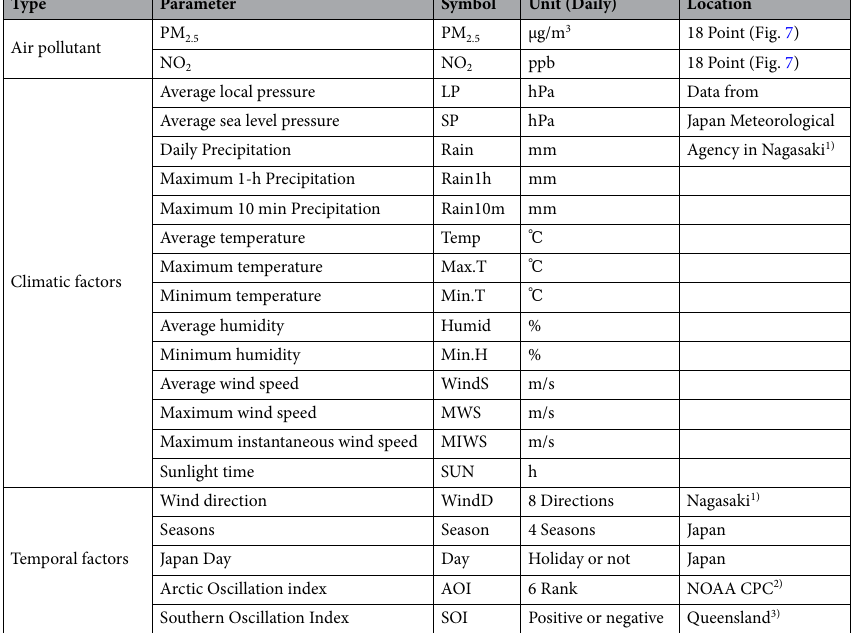
Table 6. Parameters for the random forest model. a www. jma. go. jp. b www. cpc. ncep. noaa. gov/ produ cts/ precip/ CWlink/ daily_ ao_ index/ ao. shtml. c www. longp addock. qld. gov. au/ soi. *Time lag data (1–7 days past each